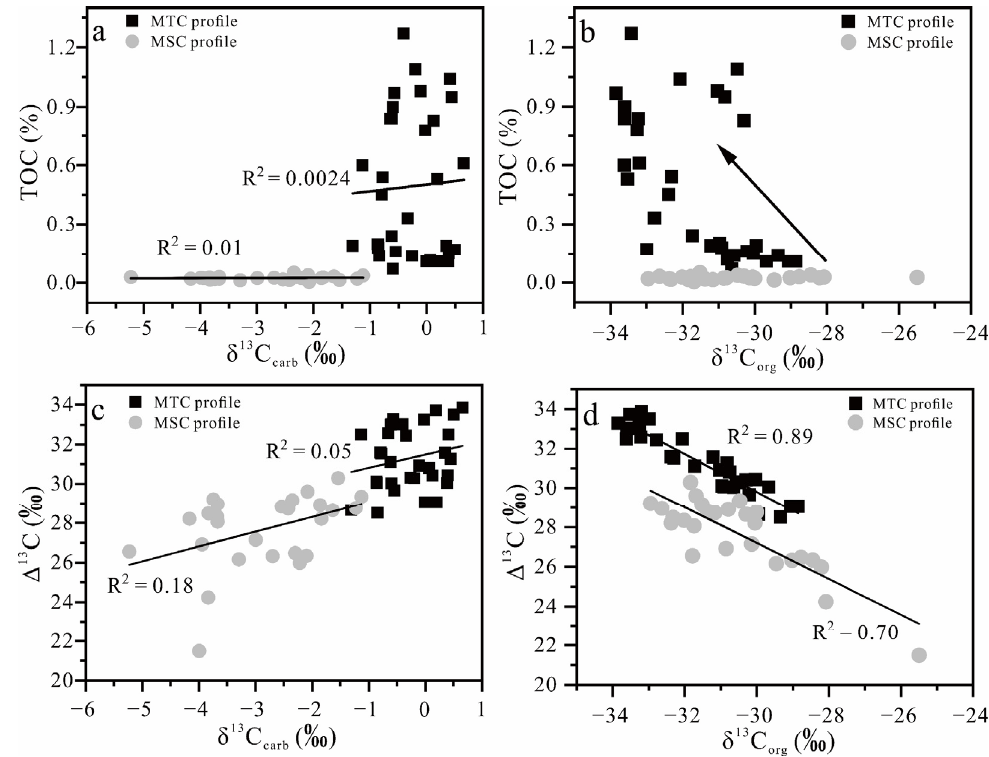
Figure 6. The scatter diagrams between δ 13 C and TOC. ( a ) δ 13 C carb and TOC, ( b ) δ 13 C org and TOC, ( c ) Δ 13 C and δ 13 C carb , and ( d ) Δ 13 C and δ 13 C org . The MSC data were obtained from [18].